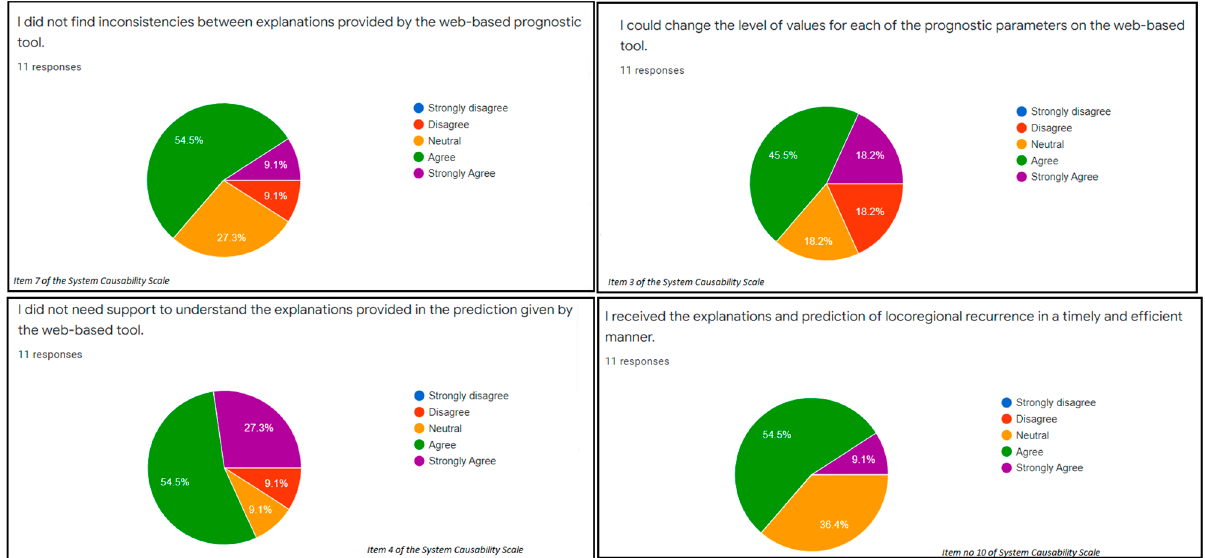
Figure 4. Measuring the essential components of explainability using the System Usability Scale. The fidelity includes soundness and completeness (items 7 and 3 of SUS), while interpretability includes parsimony and clarity (items 4 and 10 of SUS).